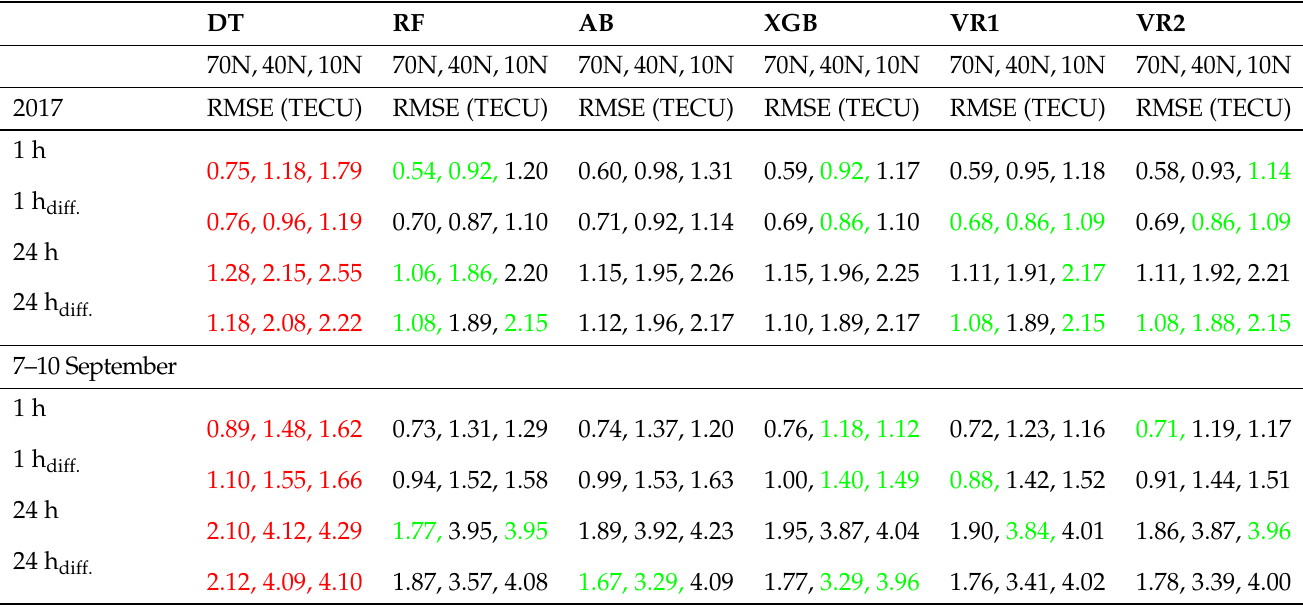
Table 5. Overview of RMSE for different machine learning models for test period of year 2017 and severe geomagnetic storm 7–10 September, 2017 for high-latitude (10E 70N), mid-latitude (10E 40N) and low-latitude (10E 10N) VTEC. The subscript diff. indicates models trained on differenced data. The maximum and minimum values of the RMSE are marked in red and green,